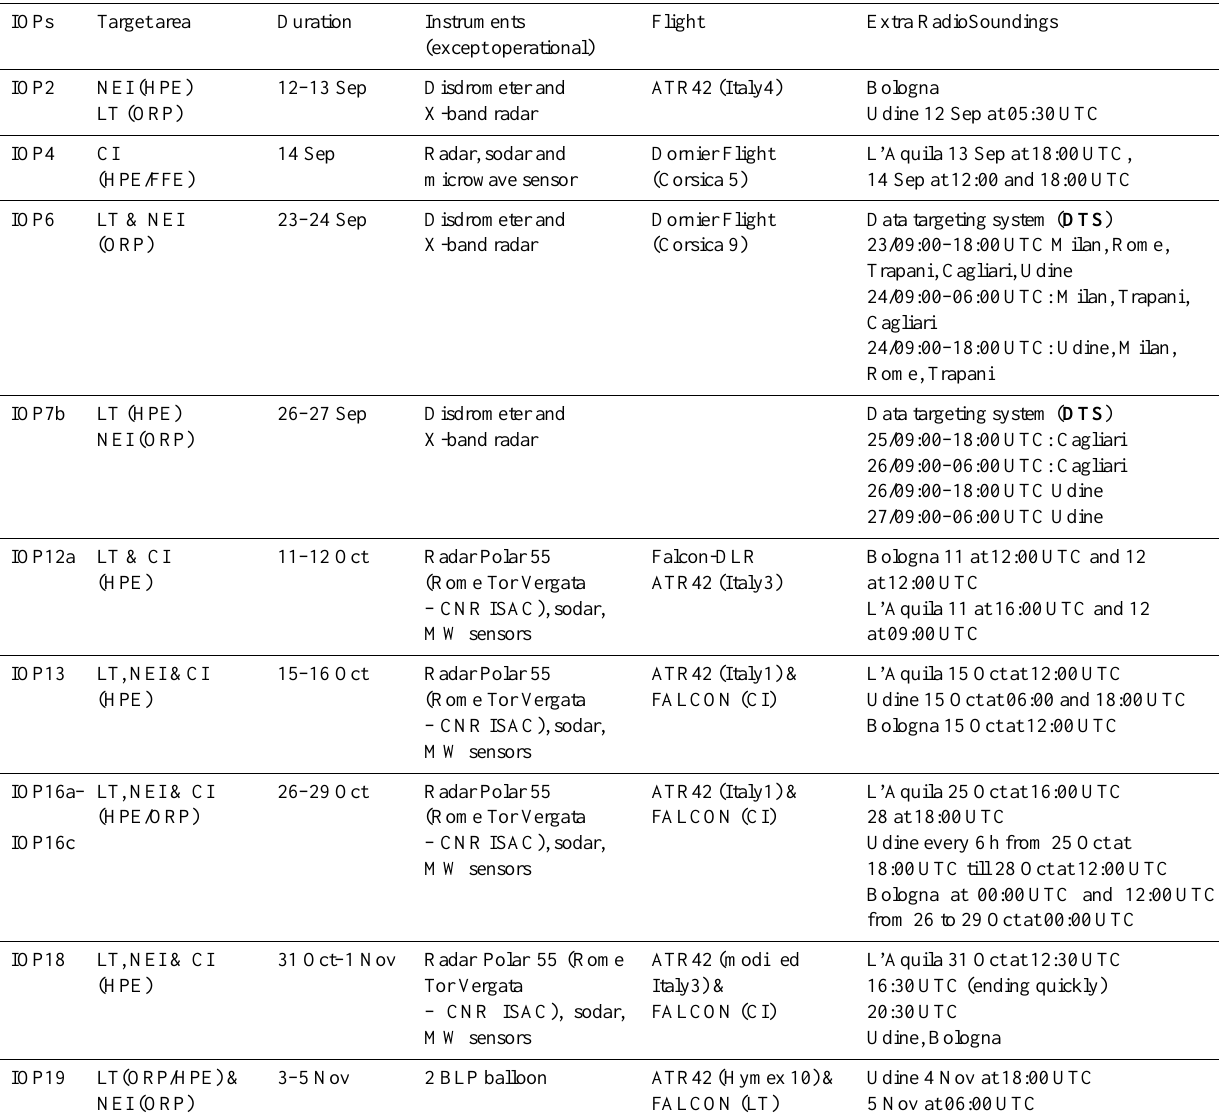
Table 5. Summary of the Italian IOPs during SOP1. In the table the affected hydro-meteorological sites, the duration, the instruments specifically activated, and the flight and extra soundings (RS) are